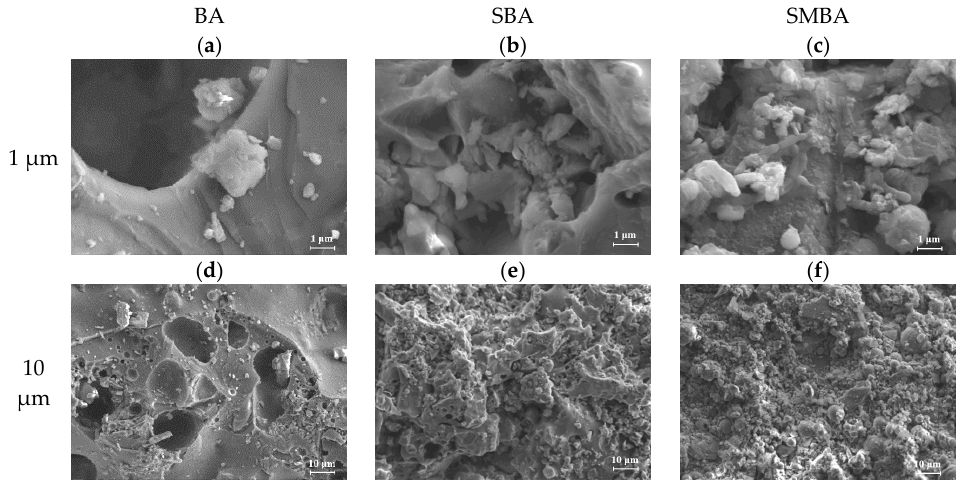
Figure 1. SEM image of absorbents ( a ) BA (1 µ m), ( b ) SBA (1 µ m), ( c ) SMBAA (1 µ m), ( d ) BA (10 µ m), ( e ) SBA (10 µ m), ( f ) SMBA (10 µ